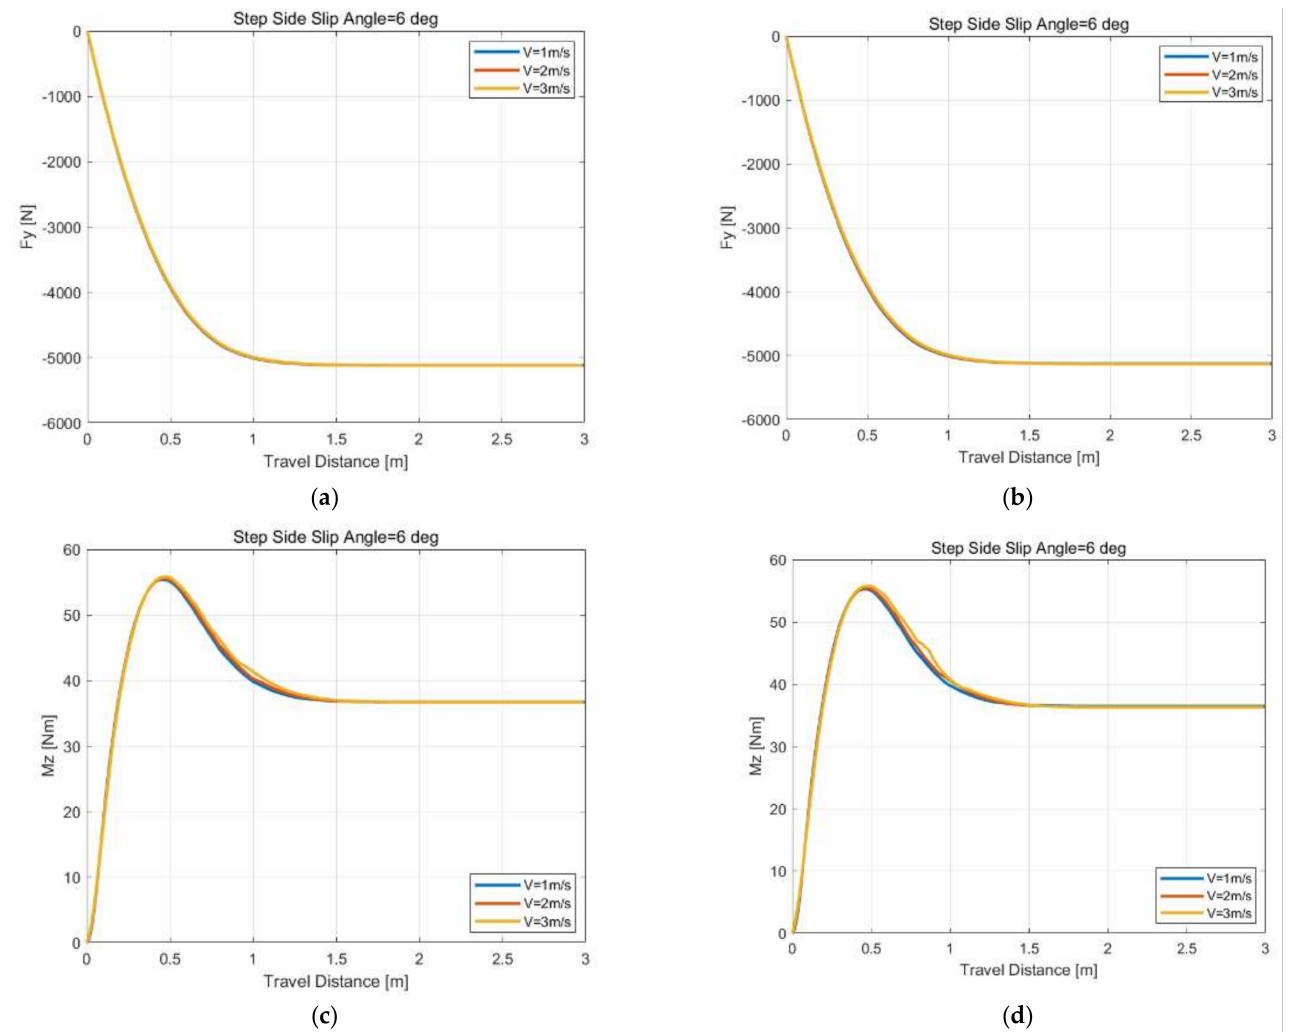
Figure 12. Response of lateral force and aligning moment under side slip angle input. ( a ) Response of lateral force using the proposed method. ( b ) Response of lateral force using the reference method. ( c ) Response of aligning moment using the proposed method. ( d ) Response of aligning moment using the reference